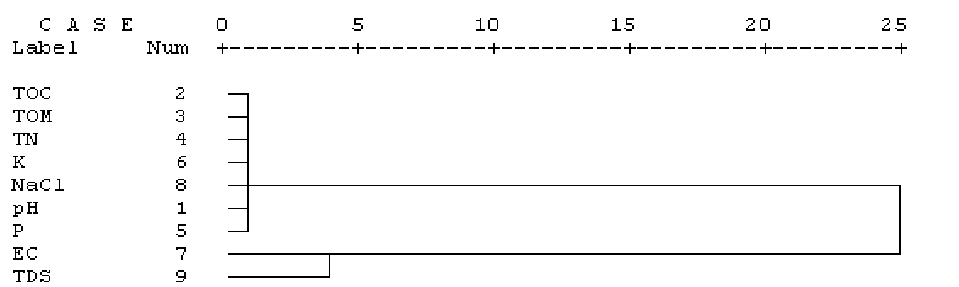
Fig. 4: Hierarchical cluster